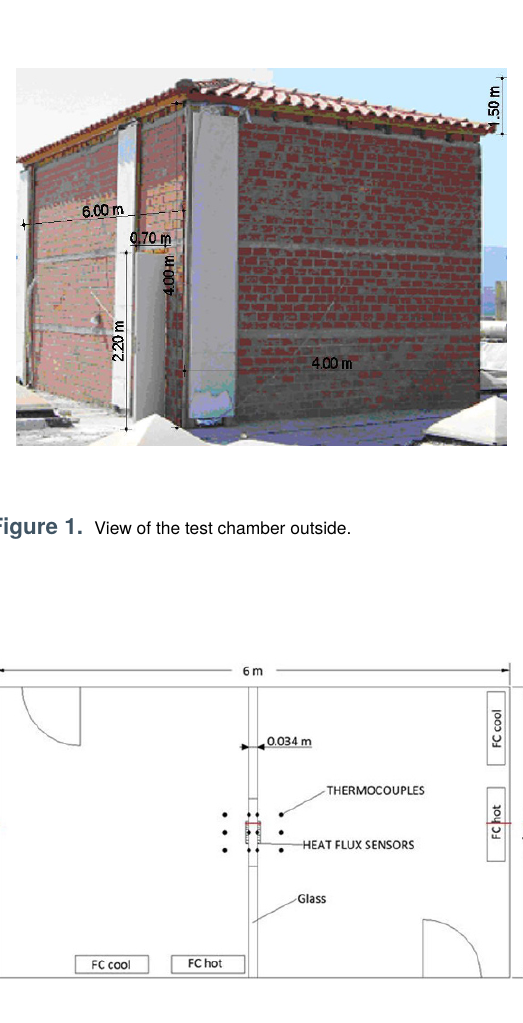
Figure 2. View of the test chamber inside. FC: Fan coils